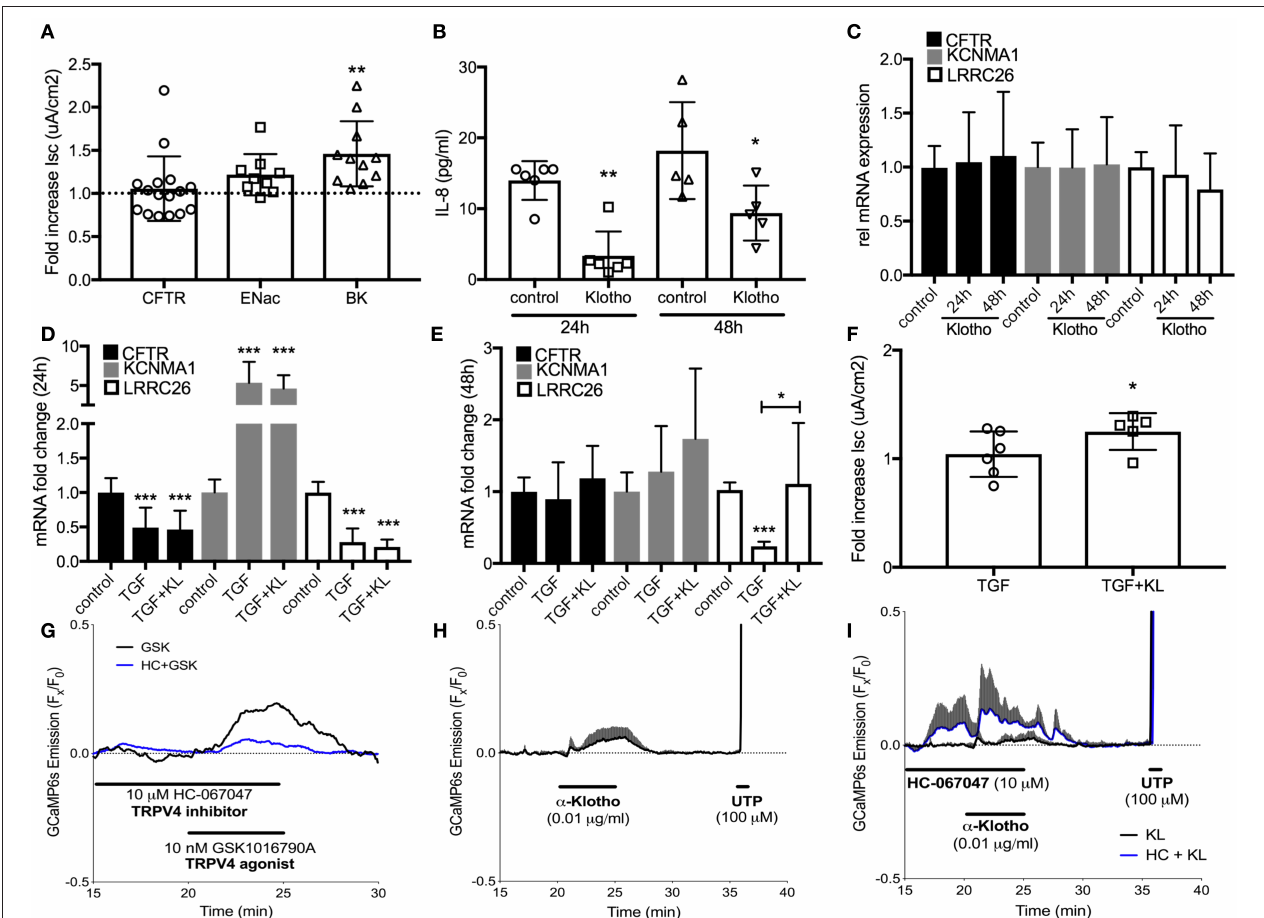
FIGURE 3 | (A) Effect of treatment with recombinant KL on the activation of CFTR, ENaC, and BK channels, assessed in human ALI cultures using Ussing chambers. (B) Effect of klotho overexpression on basolateral IL-8 secretion in HBECs. (C) Bar graphs indicating changes in relative mRNA expression of CFTR and BK channels subunits after treatment with KL, (D) TGF- β (2.5ng/mL) after 24h and (E) 48h. (F) Effect of TGF- β ± KL on BK channel conductance in HBEC. (G) 10nM GSK1016790A, a TRPV4-selective agonist, transiently increases intracellular calcium in GCaMP6s expressing HBECs. This response is partially blocked in the presence of TRPV4 antagonist HC-067047 (10 µ M, n = 1). (H) Acute KL exposure (0.01 µ g/ml, 5min) transiently increases intracellular calcium ( n = 3). (I) Pre-exposure to HC-067047 amplified KL-mediated calcium effects. 100 µ M UTP served as a positive control for calcium influx ( n = 3 independent experiments from 3 to 5 different lungs showing mean ± S.E. with * P < 0.05, ** P < 0.01, and *** P <